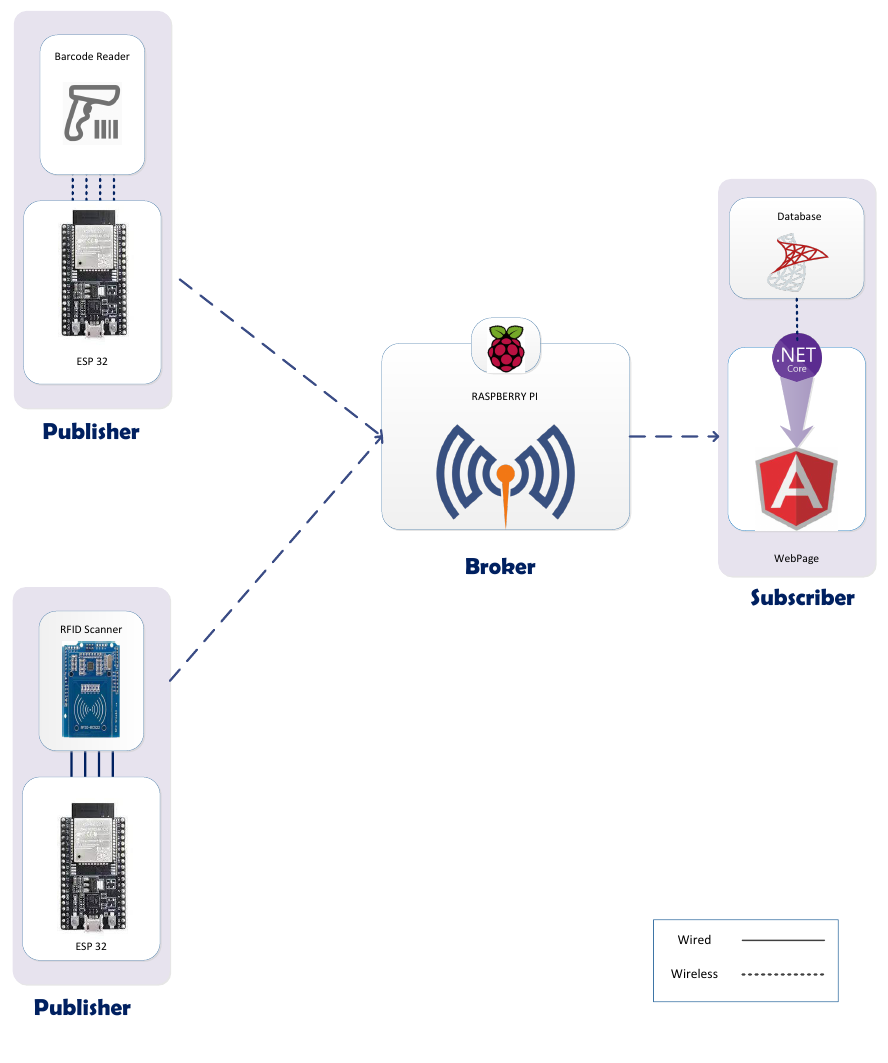
Figure 10. Block diagram of the prototype.